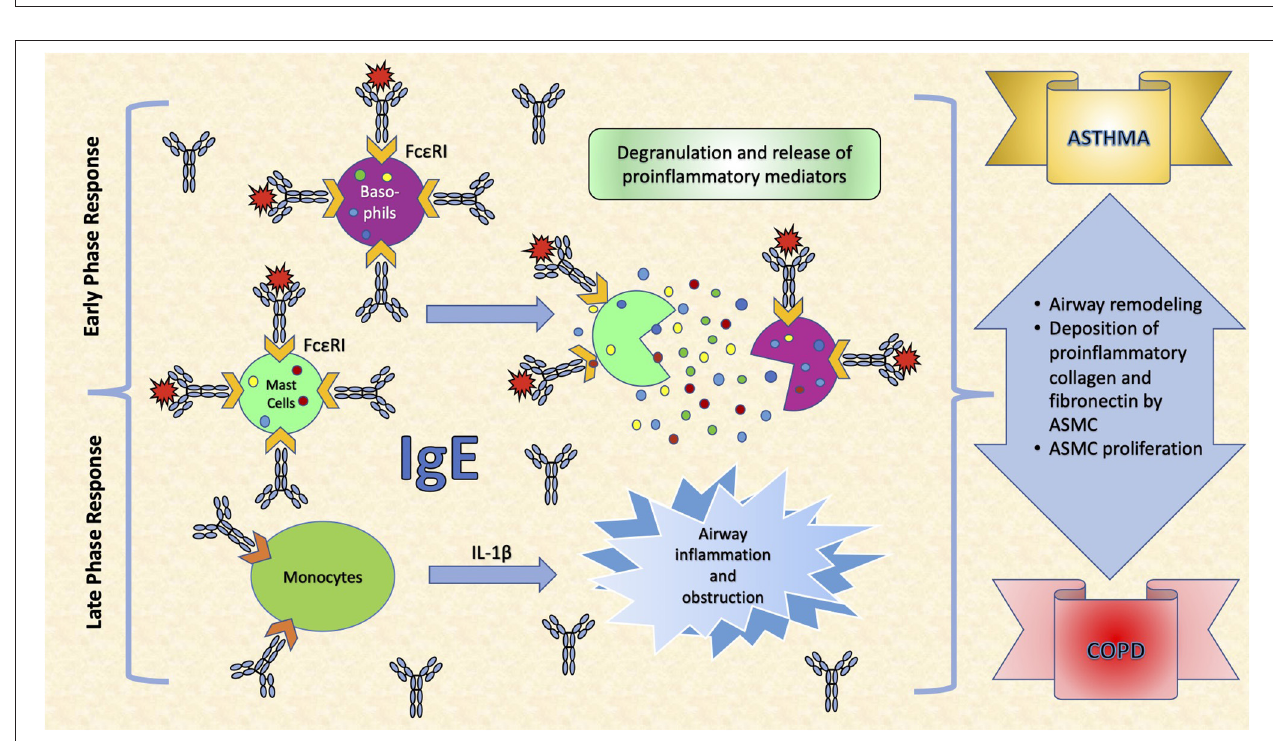
FIGURE 2 | The effects of IgE in the respiratory system. IgE binds almost irreversibly to the high affinity IgE receptor (Fc ε RI) on the surface of mast cells or basophils to create allergen receptors. A subsequent exposure to the antigen leads to cross-linking of the IgE:Fc ε RI complex, degranulation of the cells and release of inflammatory mediators, leading to symptoms such as rhinorrhea, sneezing, nasal congestion and itching. Interleukin (IL)-1 β is a very important pro-inflammatory cytokine that mediates the inflammatory response, and its expression may be induced in monocytes, as a response to increased IgE levels. This leads to airway inflammation and obstruction, an important determinant in COPD. Moreover, IgEs increase airway remodeling by increasing deposition of pro-inflammatory collagens and fibronectin by airway smooth muscle cells (ASMC) and stimulating their proliferation.